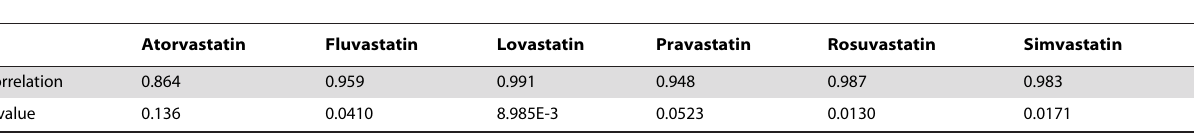
Table 1. Cidal activity of statins against somules in vitro : dose-response correlations between the automated and manual